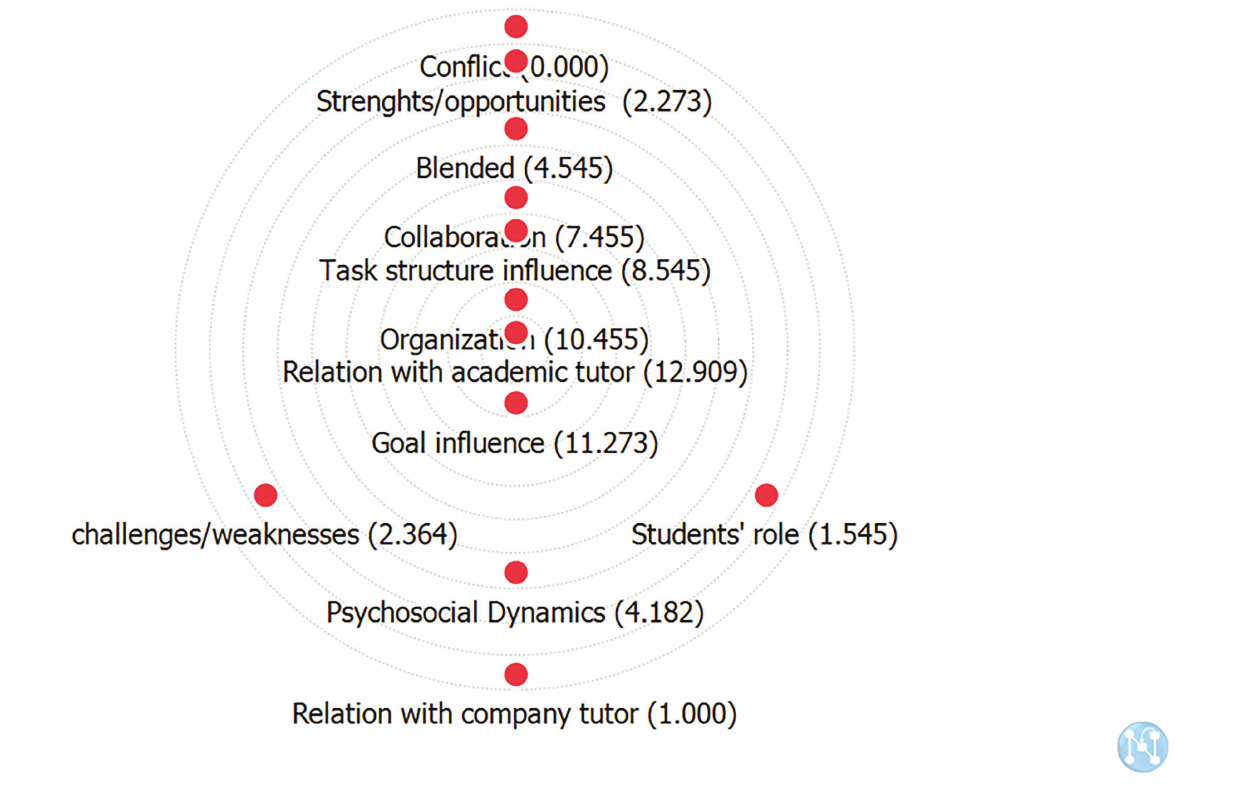
FIGURE 3 | Centrality analysis of co-occurrences in the chats with only academic tutors